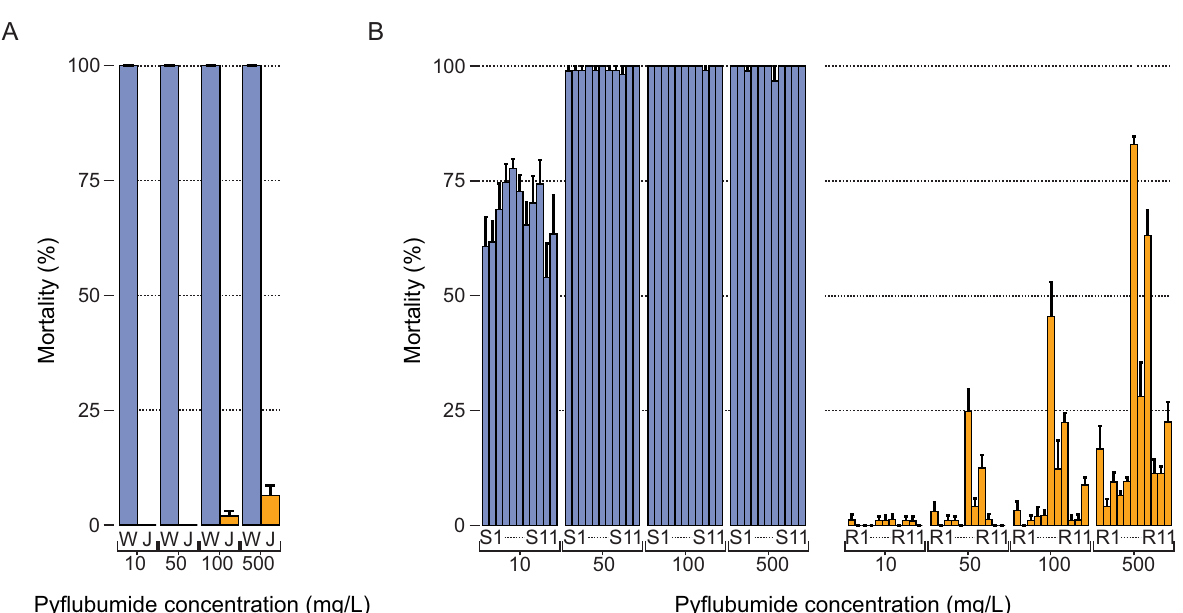
Fig 2. Selection of segregating populations resulted in high levels of pyflubumide resistance. (A) Mortality after exposure to 10, 50, 100, and 500 mg/L of pyflubumide of WasX (W) and JPR-R1 (J) (depicted in blue and orange, respectively), the two parental strains of the BSA cross. Error bars represent standard errors. Mortality was significantly different at every pyflubumide dose between JPR-R1 and WasX (p < 0.0001). (B) Mortality after exposure to 10, 50, 100, and 500 mg/L of pyflubumide of control (S1-S11) and pyflubumide-selected (R1-R11) populations (depicted in blue and orange, respectively). Error bars represent standard